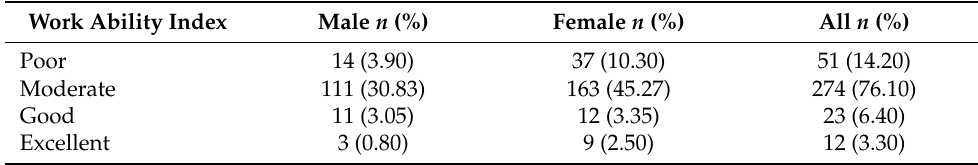
Table 3. Work ability index (WAI) of seven-dimension summative index ( n = 360).